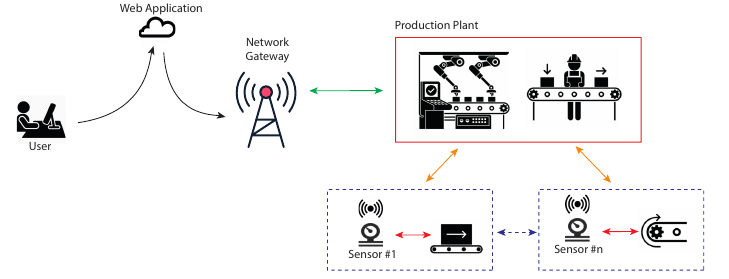
Figure 4. Smart production